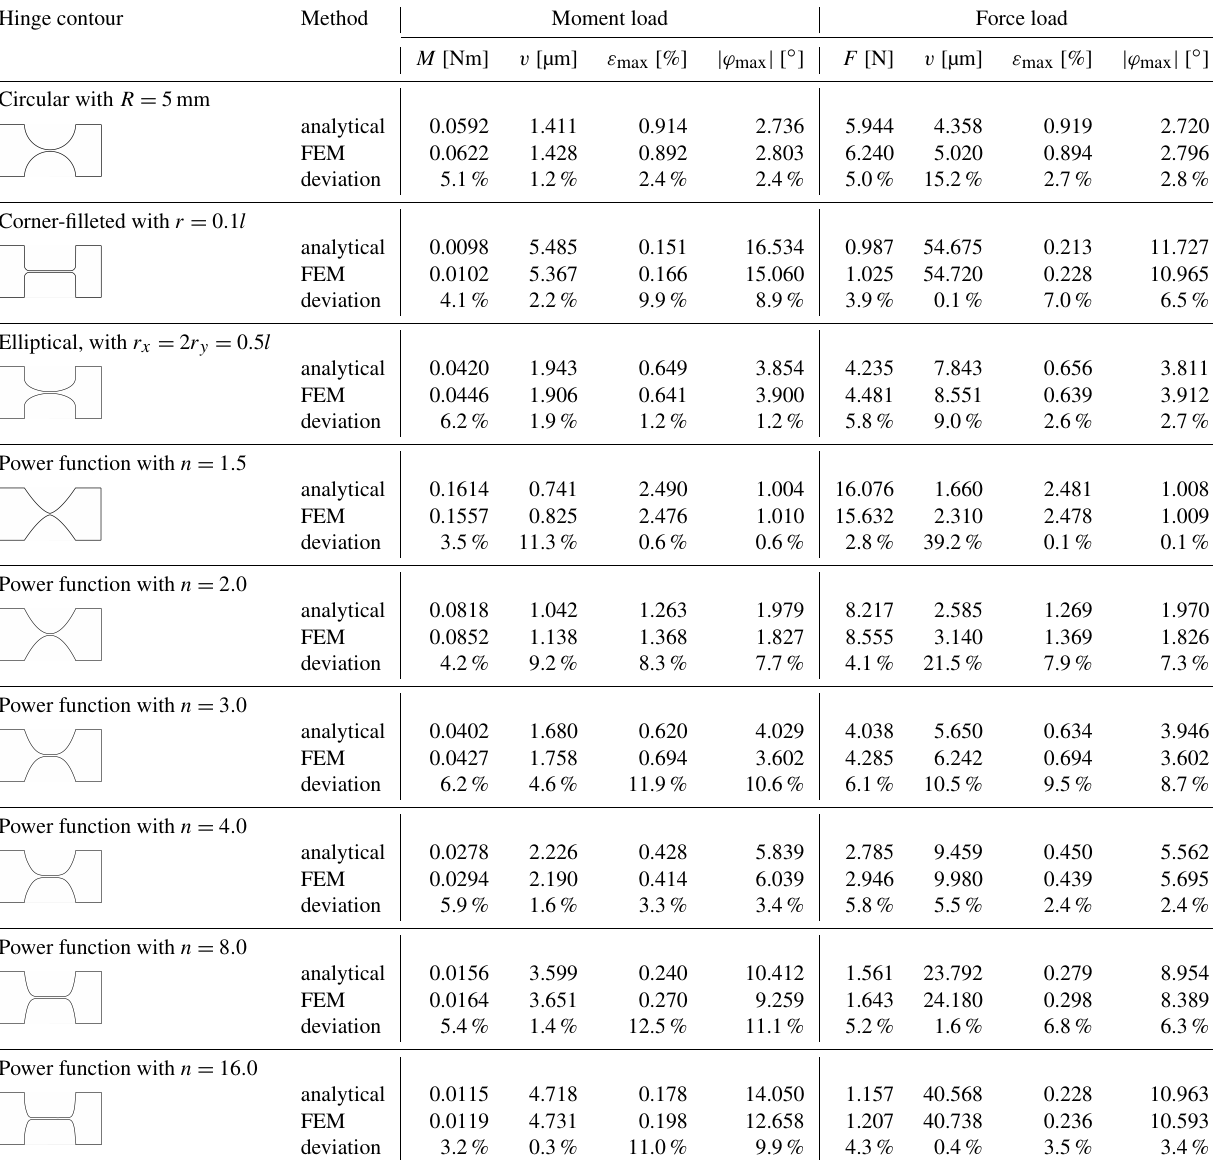
Table 3. FEM-based verification and comparison of the contour-specific and load-dependent results for a discrete angular deflection of | ϕ | = 5 ◦ ( β L = 2, β l = 1, β h = 0 . 03, β w = 0 . 6) with specification of the relative deviations to the analytical design tool solution. Hinge contour